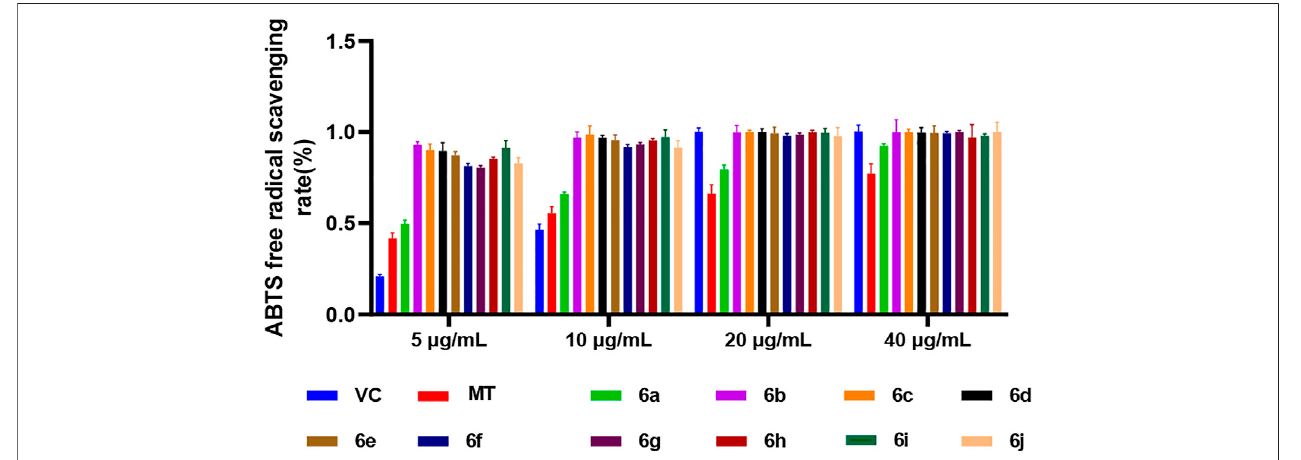
FIGURE 1 | ABTS method for measuring the antioxidant activity of 6a~ 6j.